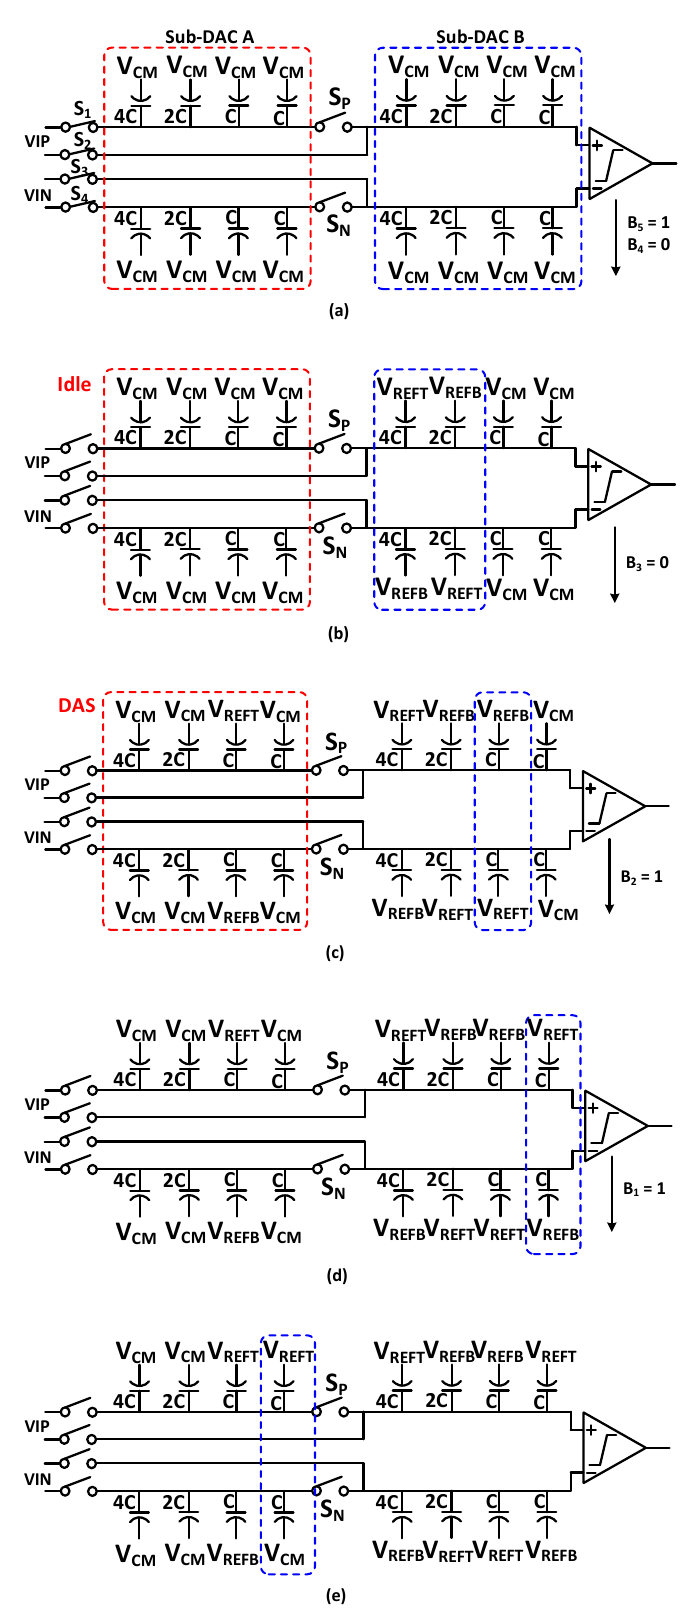
Figure 4. Example of proposed switching technique for 6-bit SAR architecture ( a ) Sampling phase ( b ) First two conversion cycles ( c ) 3rd conversion cycles ( d ) 4th conversion cycle ( e ) 5th conversion cycle.